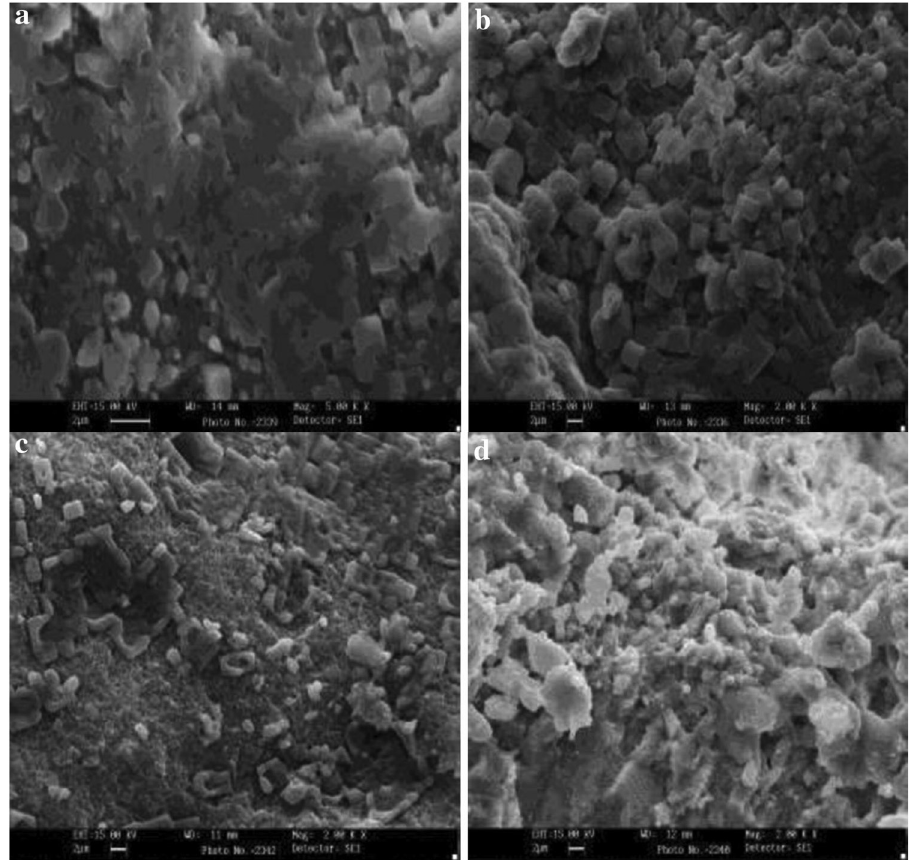
Figure 8: SEM micrograms of the NP absorbed by the reservoir rock. Clay NP: ( a ) sandstone sample and ( b ) carbonate sample. SiO 2 NP: ( c ) sandstone sample and ( d ) carbonate sample [ 189 ]